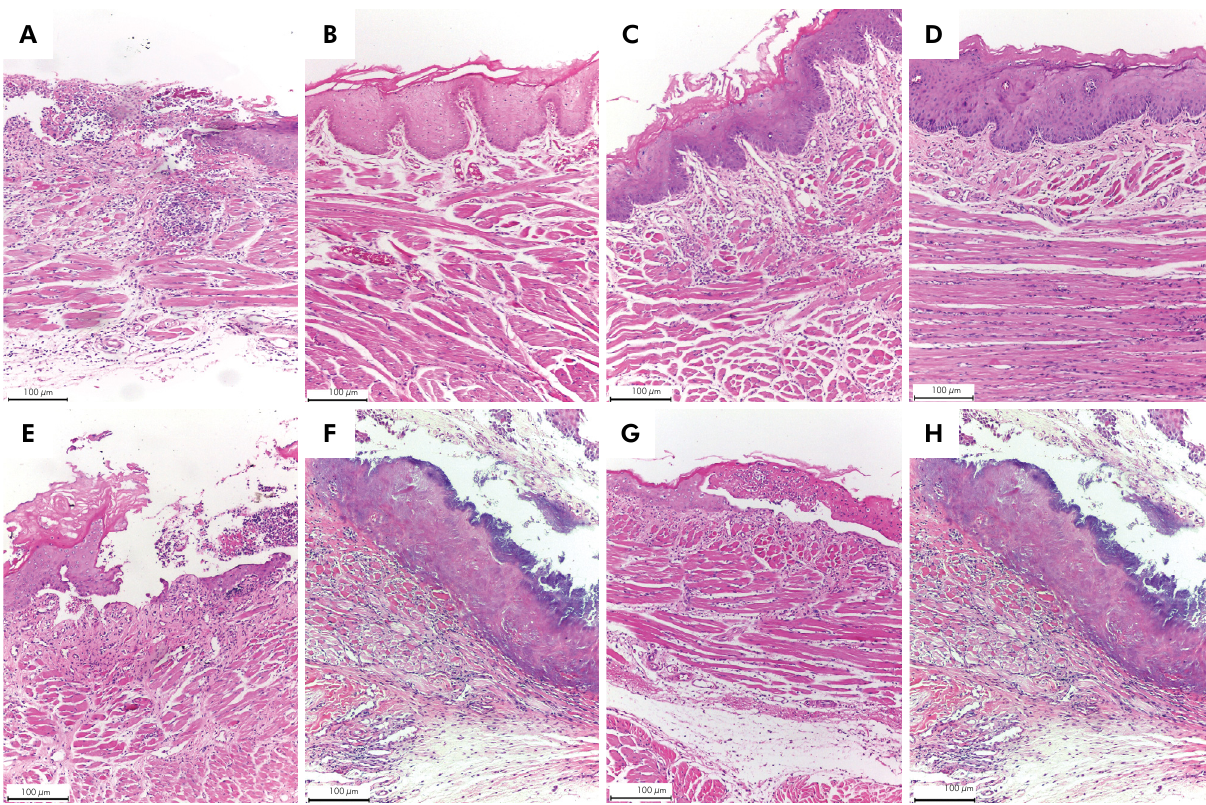
Figure 3. Light microscopy of the jugal mucosa. Group GC: A - Mucosal ulceration covered by a fibrin-leukocyte deposit; B - Full mucosal re-epithelialization and discreet submucosal inflammatory infiltration. Group GPROB: C and D - Unchanged epithelium. Group G5-FU: E - Mucosal ulceration covered by fibrin-leukocyte crust; F - Extensive mucosal ulceration covered by fibrin-leukocyte crust and bacterial colonies. Group G5-FU/PROB: G - Partial re-epithelialization of the epithelium with discreet stromal lymphocytic inflammatory infiltration; H - Full mucosal re-epithelialization and moderate submucosal inflammatory infiltration. The left column shows assessment at day 3, whereas the right column shows assessment at day 7. Hematoxylin-eosin, 200x